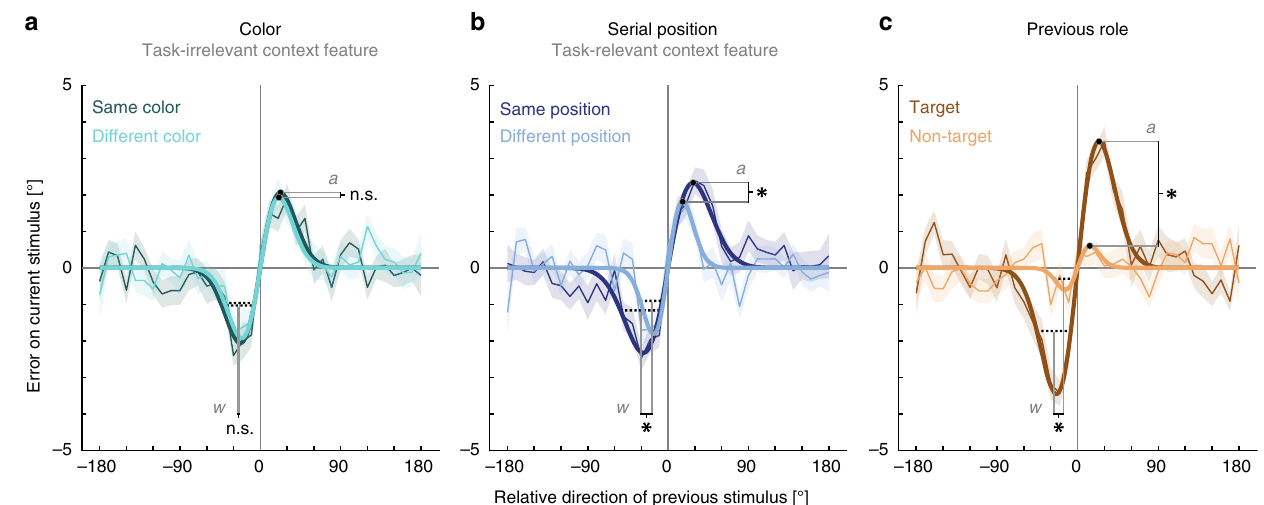
Fig. 3 Results of Experiment 2. Serial dependence (ordinate) is shown as a function of the motion direction difference (abscissa) between an item of the previous trial and the target of the current trial. For details see Fig. 2 and Methods. Serial dependence was revealed by the group averages of response errors (thin lines), with the corresponding shaded regions depicting the standard error of the group mean. A DoG model (shown as bold lines) was fi tted to the response errors to estimate the systematic response bias. Solid lines indicate a signi fi cant bias, whereas dashed lines depict a non-signi fi cant bias. Black fi lled circles and black dashed lines are showing the amplitudes and FWHMs of the DoG fi ts and are accompanied by a symbol indicating the result of the direct comparison of the parameter estimates (one-sided permutation tests, 49 participants). Asterisks indicate a p -value < 0.05 and ‘ n.s. ’ indicates a non- signi fi cant result with a p -value ≥ 0.05. a Serial dependence did not differ signi fi cantly between items with the same color and different colors (amplitude difference: p = 0.347, width difference: p = 0.228). b Both amplitude and width of serial dependence were greater between items with the same serial position than between items with different serial positions (amplitude difference: p = 0.009, width difference: p < 0.001). c Both amplitude and width of serial dependence were greater for previous targets than non-targets (amplitude difference: p < 0.001, width difference: p < 0.001) Source data are provided as a Source Data fi le.